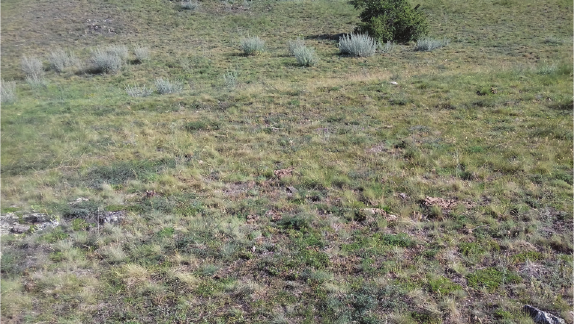
Figure 7. Subassociation bothriochloetosum ischaemi (Photo: M. Lübben).